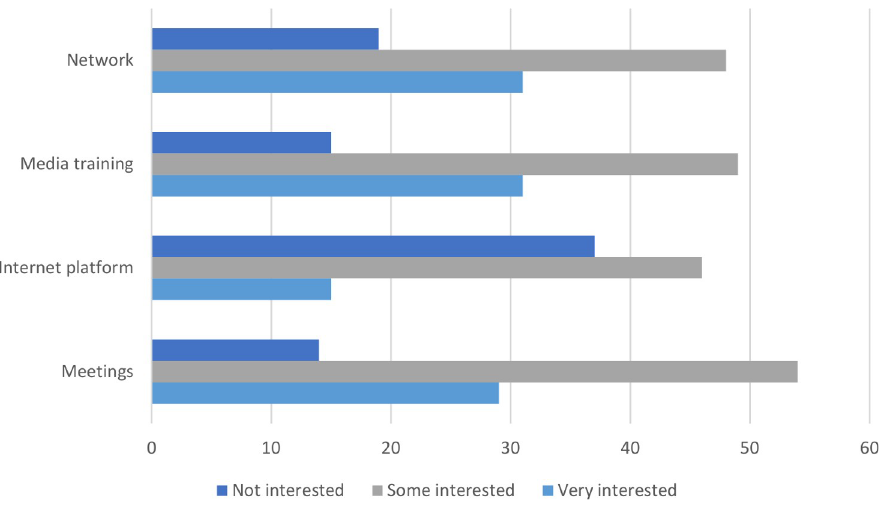
Fig 2. Experts’ interest in suggested